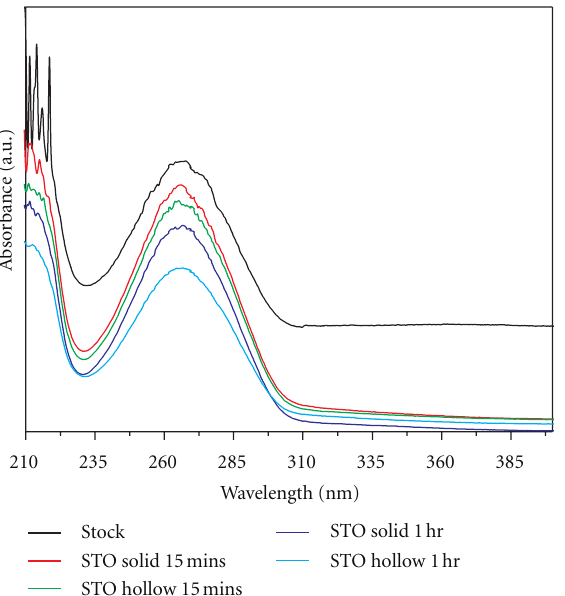
Figure 7: UV studies for (a) stock solution, (b) solid STO fibers 15mins, (c) hollow STO fibers 15mins, (d) solid STO fibers 1h, and (e) hollow STO fibers